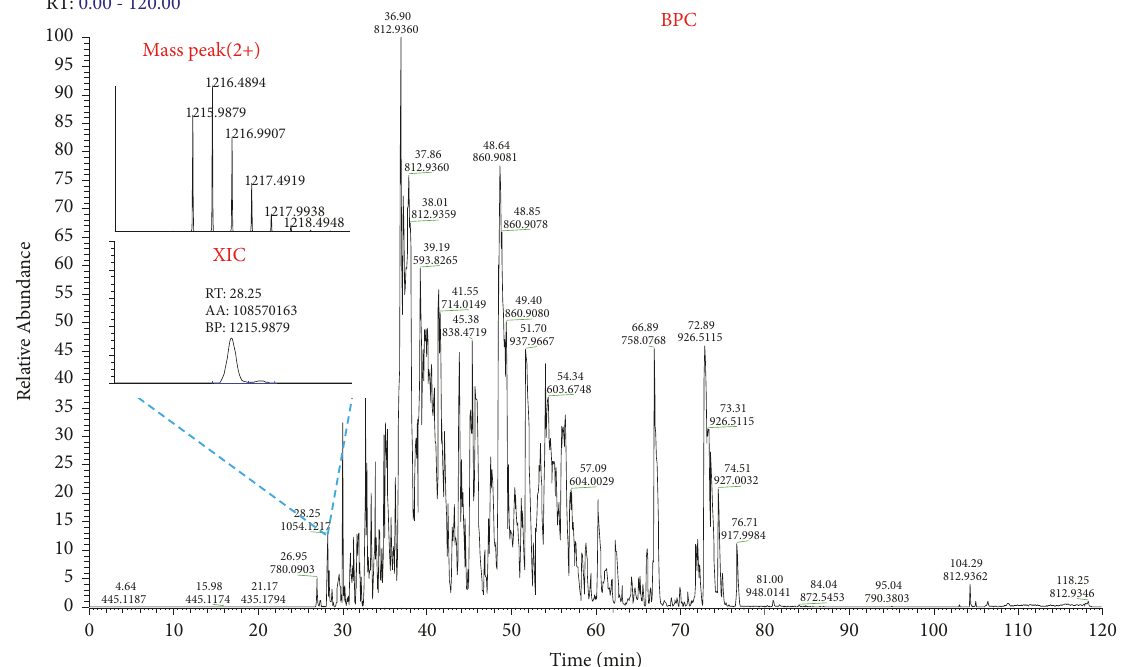
Figure 1: Base peak chromatogram (BPC) by LC-tandem MS analysis of the tryptic digests of reference rAb. The extracted ion chromatogram (XIC) of the glycopeptide EEQYNSTYR 3 3 1 0, identified as one of major components at RT 28.25 min, was also inserted together with the monoisotopic peak pattern of the